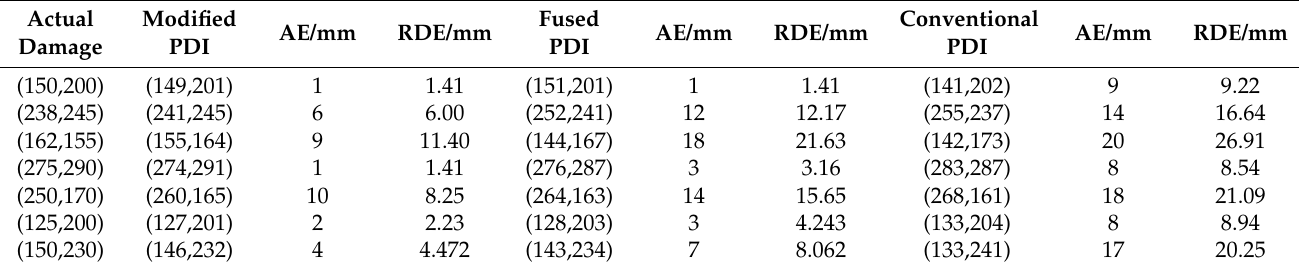
Figure 22. The imaging results of one virtual damage at location (150 mm, 230 mm) obtained by ( a ) the modified PDI method, ( b ) the fused PDI method, and ( c ) the conventional PDI method. Table 2. Comparisons of localization accuracy between different damage imaging